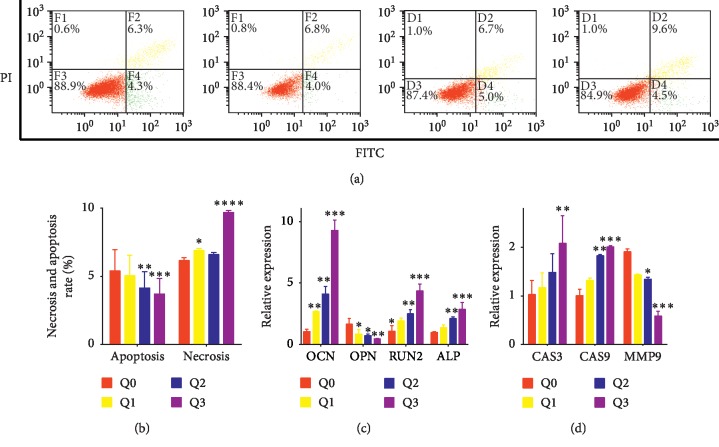
(a) Cells were treated with different material extracts for 72 h and then stained with annexin V-FITC and PI and analyzed by flow cytometry. (b) Necrosis and apoptosis rates of MG-63 cells in the material. Compared with Q0, the apoptosis rates of Q1, Q2, and Q3 were significantly higher. (c) Relative expression of osteogenic-related genes after 14 days of culture. All pro-osteogenic genes in Q3 were significantly higher. (d) Relative expression of apoptosis-related genes after 3 days of culture. All the genes were significantly in Q3 (∗p < 0.05; ∗∗p < 0.01; ∗∗∗p < 0.001) compared with the levels in Q0.